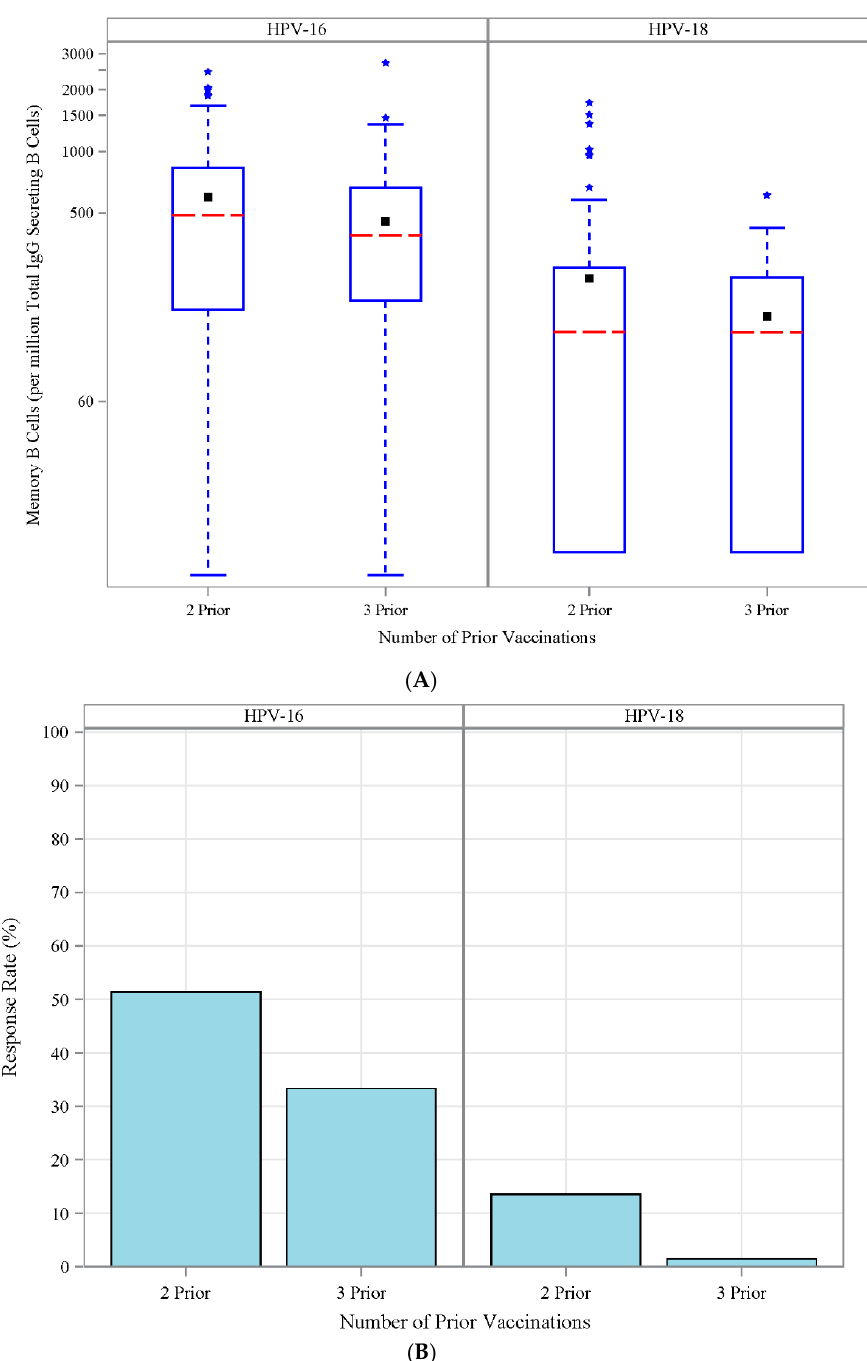
Figure 6. Frequency and proportion of MBC responders in retrospective cohorts. ( A ) Frequency of HPV-16- (left panel) and HPV-18-specific (right panel) specific memory B cells (MBCs) per millions of total IgG-secreting B cells. ( B ) Proportion of MBC responders to HPV-16- (left panel) and HPV-18- (right panel) defined as subjects with detectable ( > 455 cell / million of total IgG-secreting B cells) or L-18 ( > 450 cell / million of total IgG-secreting B cells) HPV type-specific memory B cells in retrospective cohort with 2 or 3 doses of prior 4vHPV vaccination.